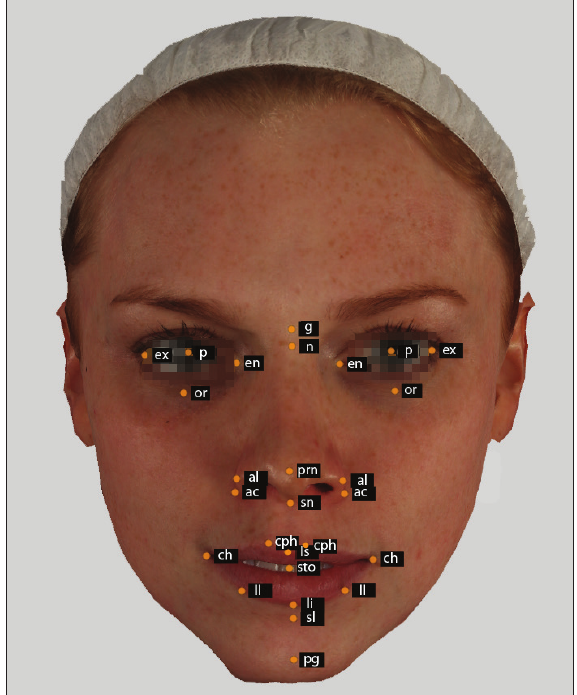
Figure 1. Facial